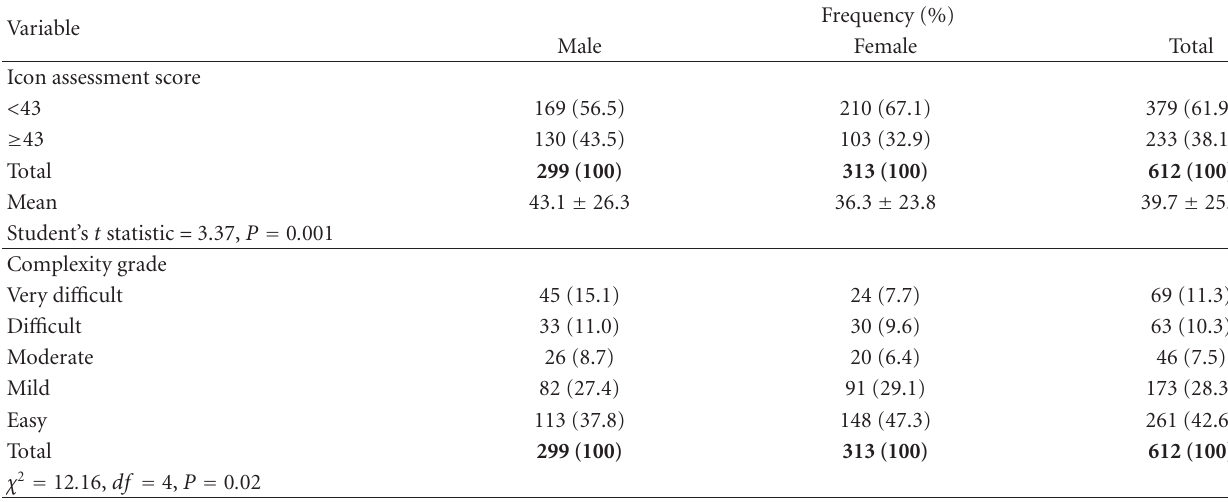
Table 1: Assessment of orthodontic treatment need and complexity by gender according to the Index of Complexity, Outcome, and Need (ICON).